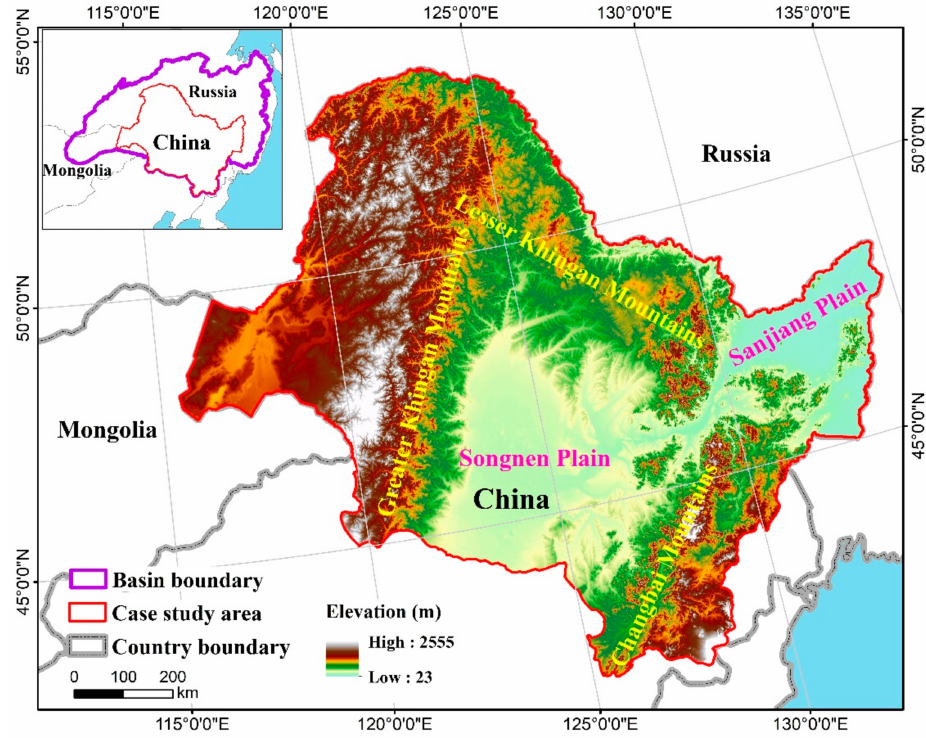
Figure 1. Spatial location and elevation of the China side of the Amur River Basin (CARB).